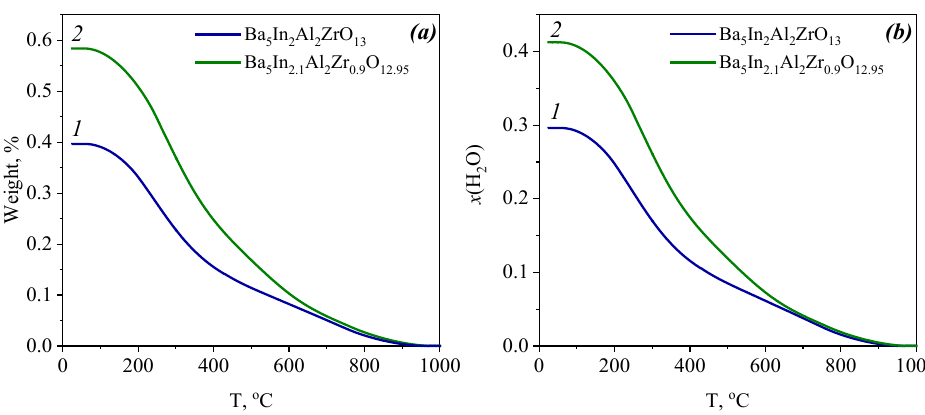
Figure 5. TG plots under cooling in wet Ar ( p H 2 O = 1.92 · 10 − 2 atm) for Ba 5 In 2 Al 2 ZrO 13 · x H 2 O ( 1 ) and Ba 5 In 2.1 Al 2 Zr 0.9 O 12.95 · x H 2 O ( 2 ); % weight gain ( a ) and the hydration degree x H 2 O ( b ).